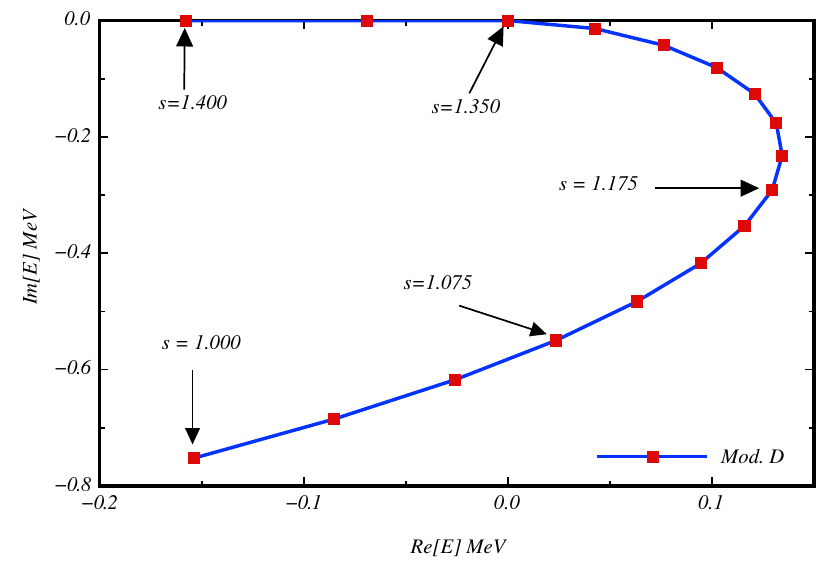
Figure 1: The trajectory of the Λ nn pole as one varies the scaling factor s between 1.0 and 1.4 for a Yamaguchi separable potential based upon the effective range pa- rameters of the Nijmegen Model